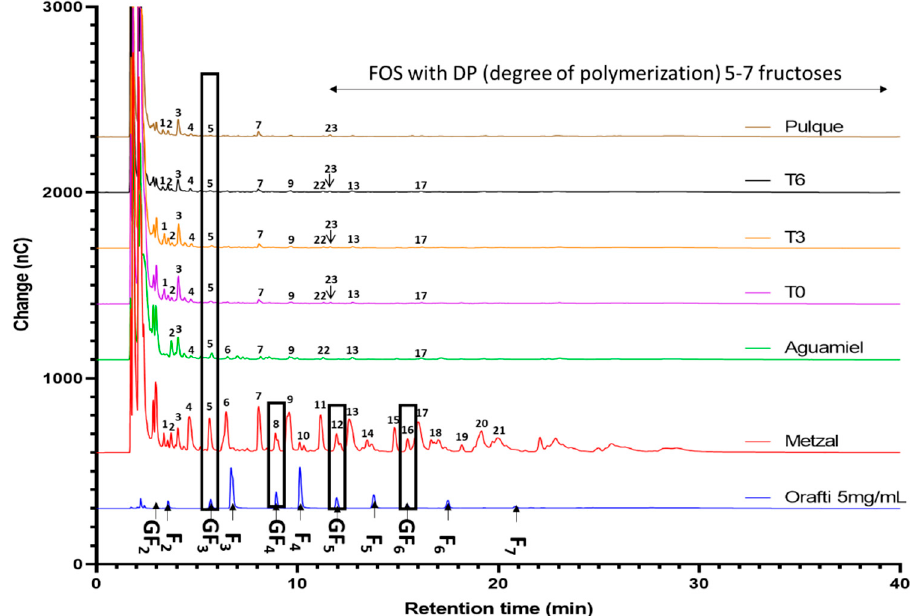
Figure 3. Fructooligosaccharide identification through HPAEC-PAD in metzal, AM, and fermentation stages. The black rectangles show the identified FOS in the analyzed samples. The chromatograms’ peak numbering (1–23) shows all the identified FOS. The blue line corresponds to FOS standard (Orafti): GF 2 : 1-Ketose, F 2 : Inulobiose, GF 3 : Nystose, F 3 : Inulotriose, GF 4 : Fructosyl-nystose, F 4 : Inulotetrose, GF 5 : Ketohexose, F 5 : Inulopentose, GF 6 : Ketoheptose, F 6 : Inulohexose, and F 7 : Inuloheptose. The chromatogram for each sample is the average of all the individual analyses, e.g., metzal = average of runs metzal 1, metzal 2, and metzal 3. Supplementary Figure S1 shows the complete chromatograms obtained through HPAEC-PAD corresponding to all analyzed triplicate